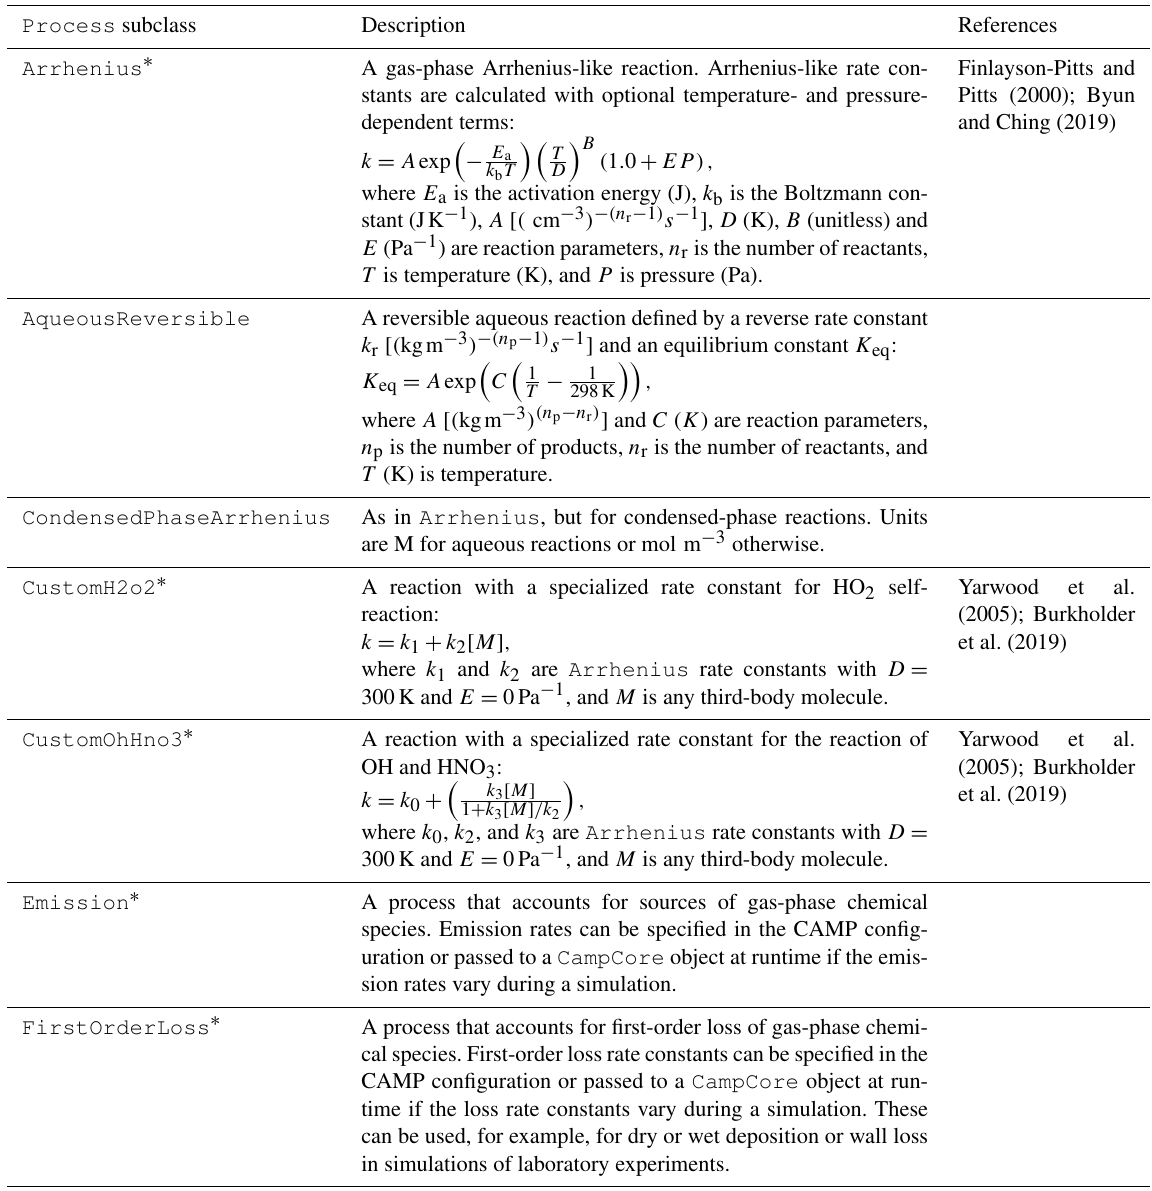
Table 2. Current implementations of the Process base class. Classes marked with an asterisk are used in the CAMP implementation example presented in Sect.